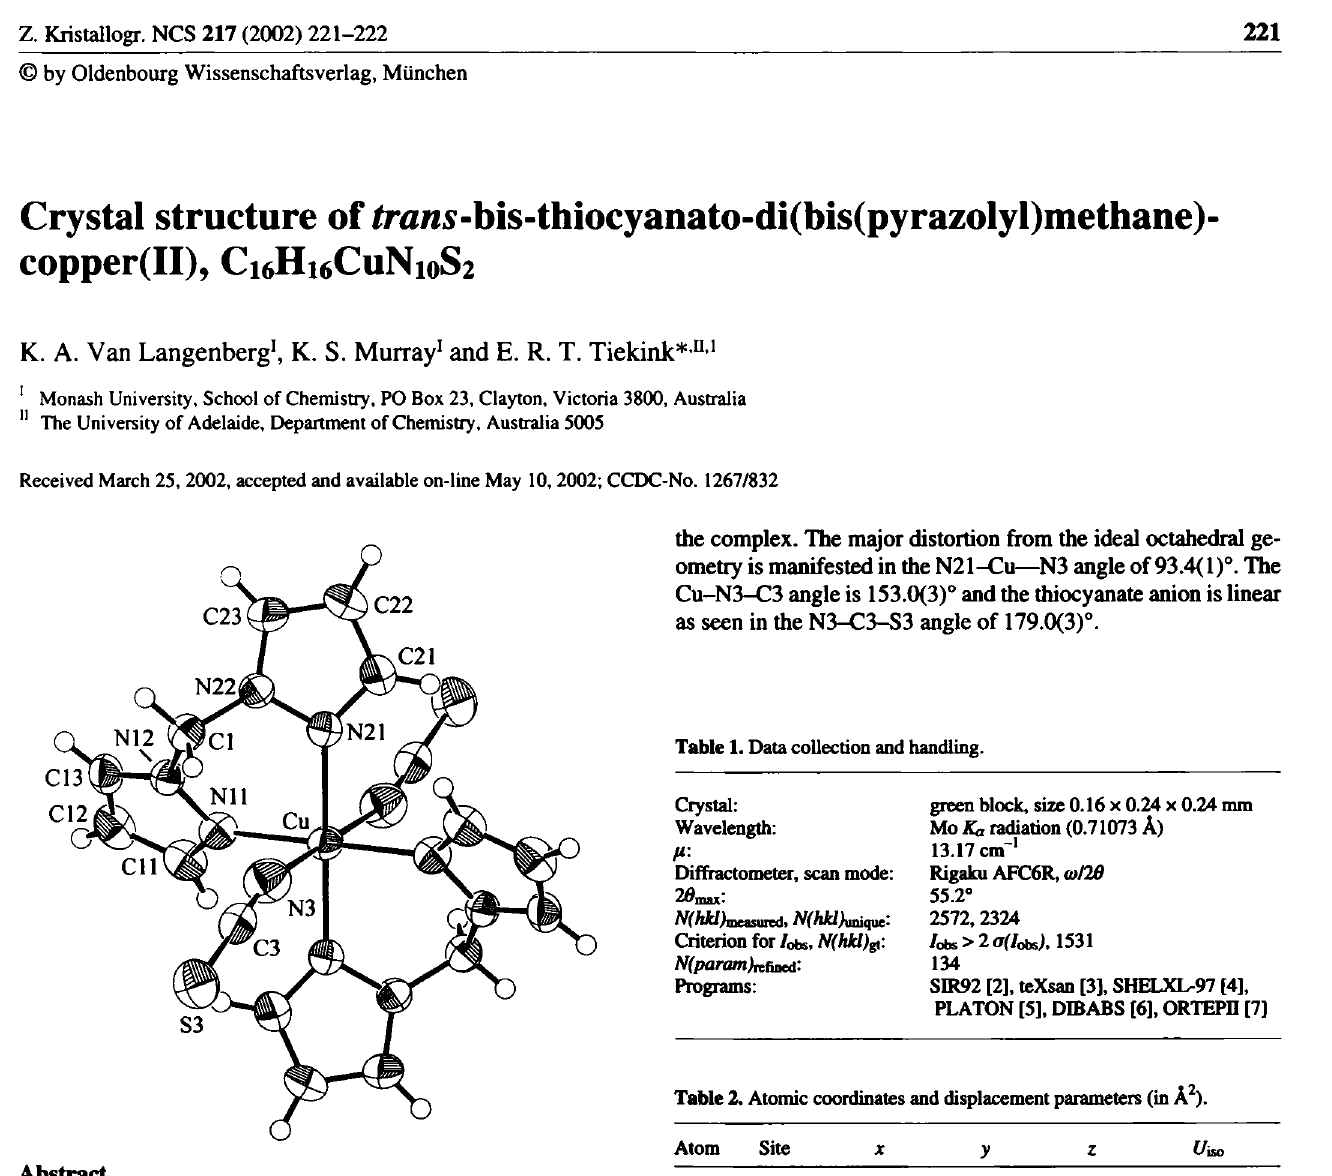
Table 2. Atomic coordinates and displacement parameters (in Â 2